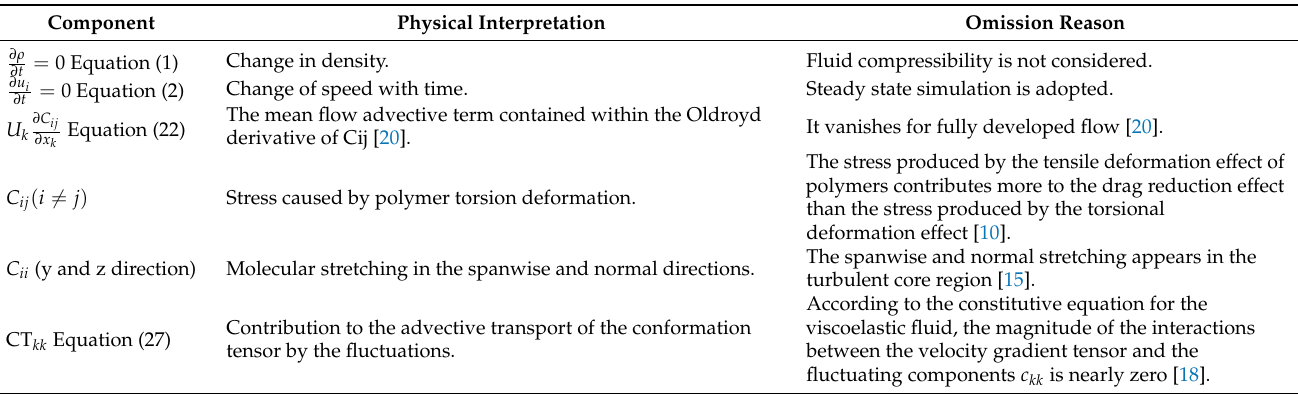
Table A1. The terms of the equations omitted from the